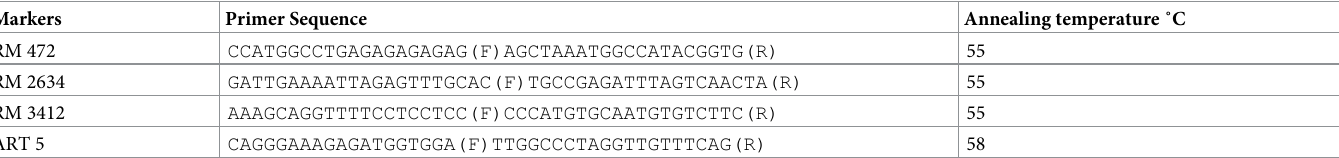
Table 2. Details of markers and their primer sequences used for foreground selection.